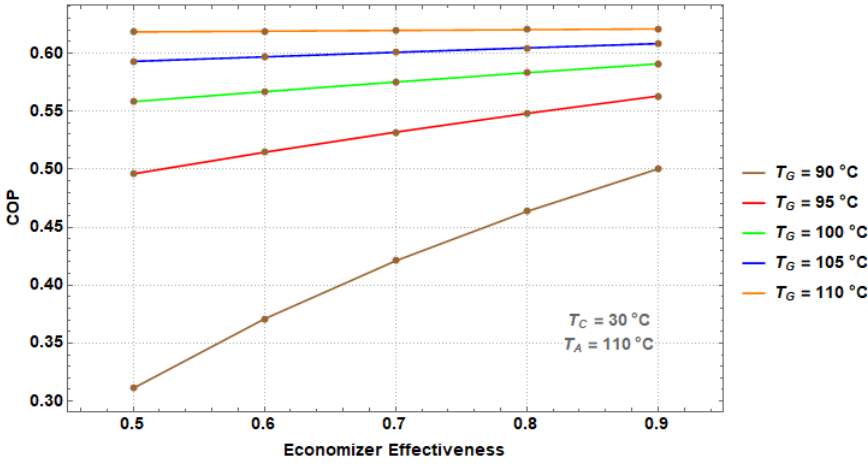
Figure 8. COP as a function of the economizer effectiveness at different T G values for the DEHT.